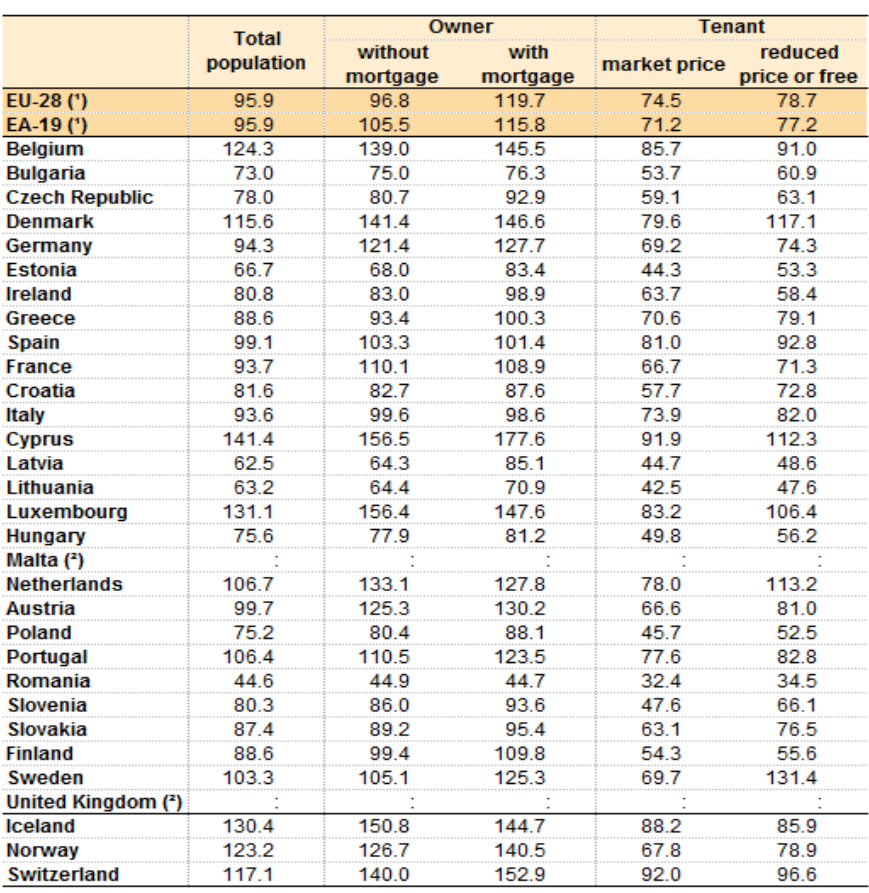
Table 2. Average size of dwelling by tenure status, m 2 ,